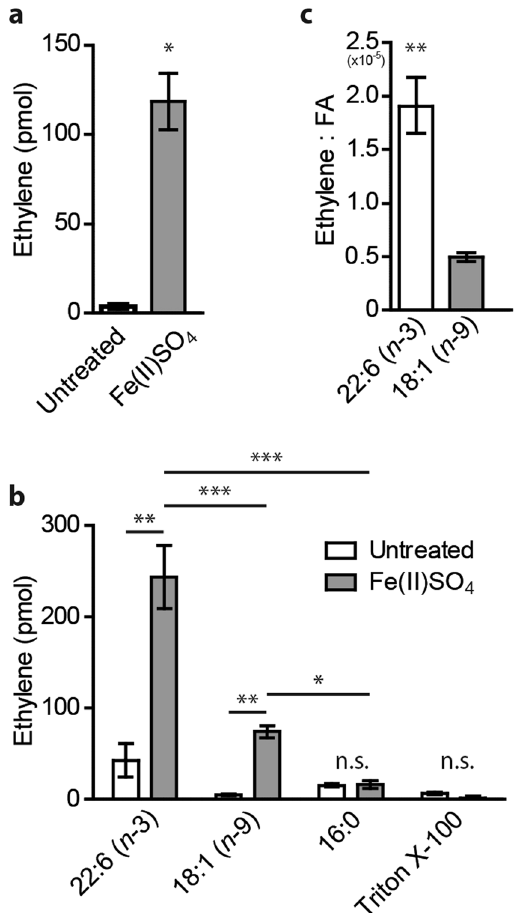
Figure 1. Ethylene forms upon peroxidation of unsaturated lipids. ( a ) Ethylene released from pig brain L- α - phosphatidylethanolamine (PE) suspended in milliQ H 2 O with 0.1% Triton X-100 and in the presence or absence of 500 µ M Fe(II)SO 4 after 30 minutes incubation (n = 3). (b) Ethylene released from cis -4,7,10,13,16,19- docosahexaeinoic acid (22:6 ( n -3)), cis -9-Octadecenoic (18:1 ( n -9)) or palmitic acid (16:0) fatty acids suspended in milliQ H 2 O with 0.1% Triton X-100 and 500 µ M Fe(II)SO 4 after 30 minutes incubation (n = 3). Triton X-100: detergent control with 0.1% Triton X-100 (n = 3). (c) Ratio of ethylene released per molecule of fatty acid (FA) for cis -4,7,10,13,16,19-docosahexaeinoic acid (22:6 ( n -3)) and cis -9-Octadecenoic acid (18:1 ( n -9)). Bar graphs show mean with SEM, asterisks indicate significance compared to untreated